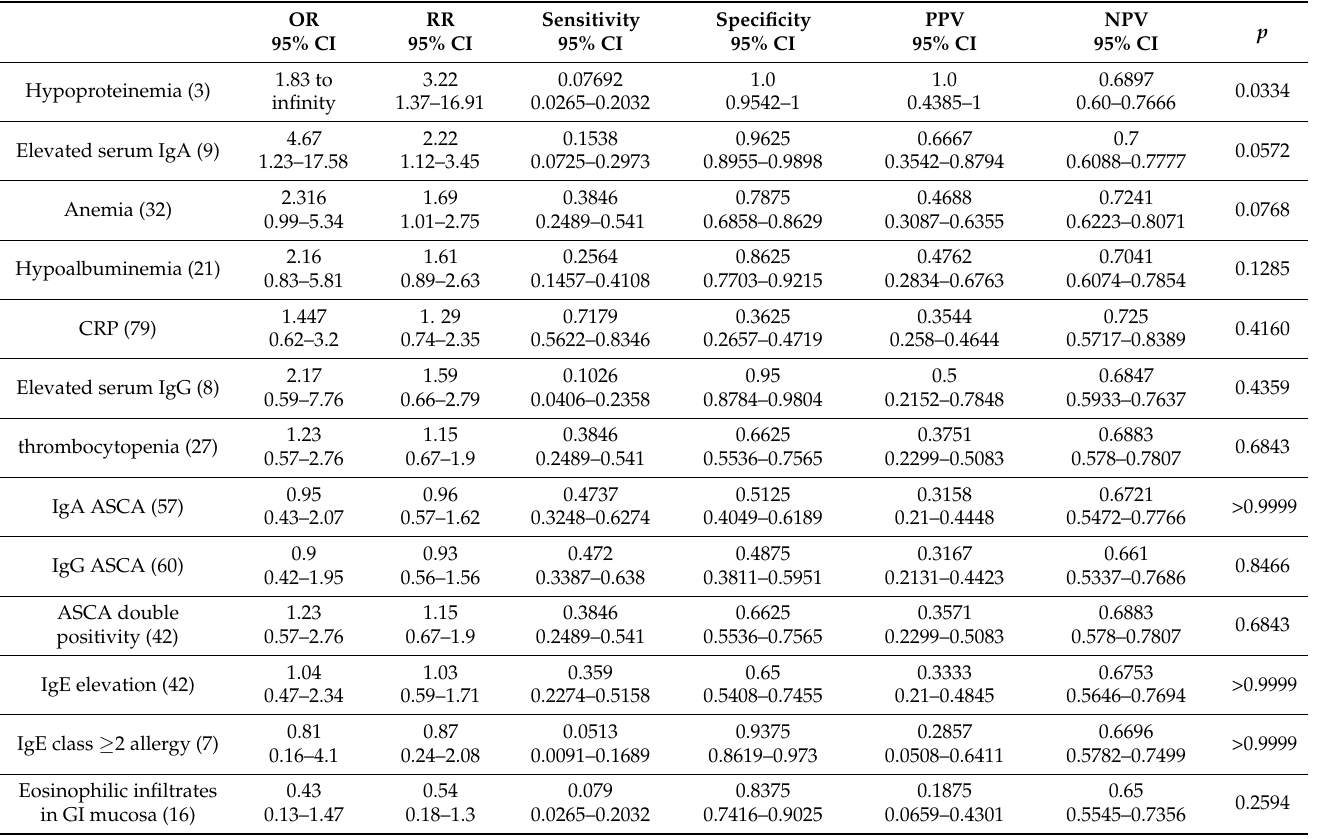
Table 4. CD laboratory tests results. In brackets the number of patients presenting with each result is